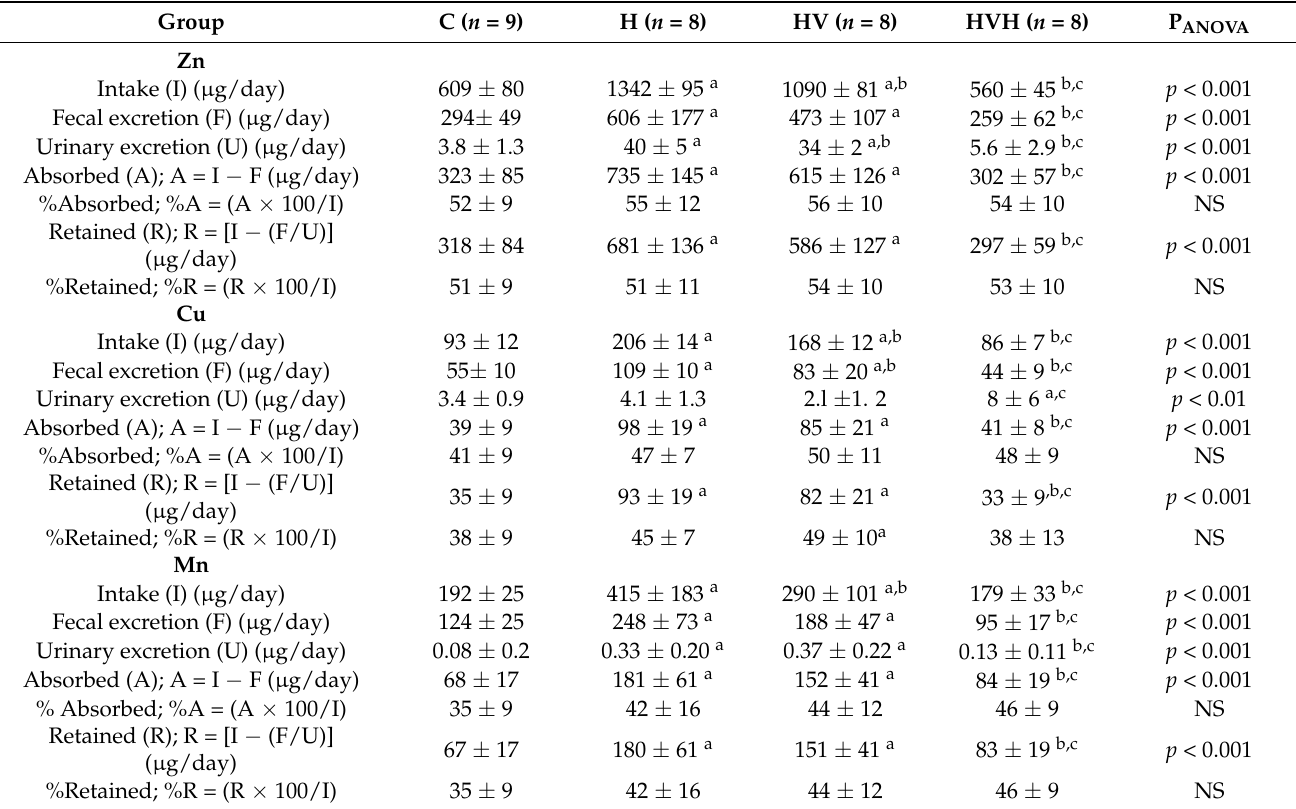
Table 1. Digestive and metabolic utilization of Zn, Cu and Mn on days 28–35 of